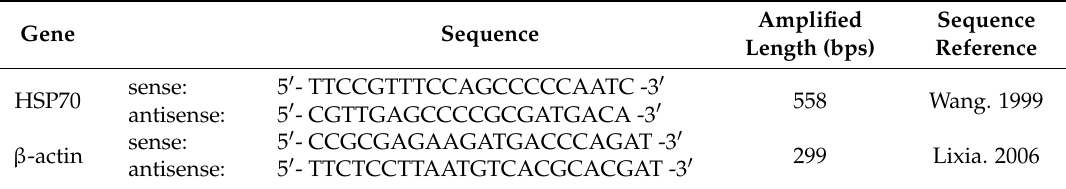
Table 1. List of primers used for RT-PCR.